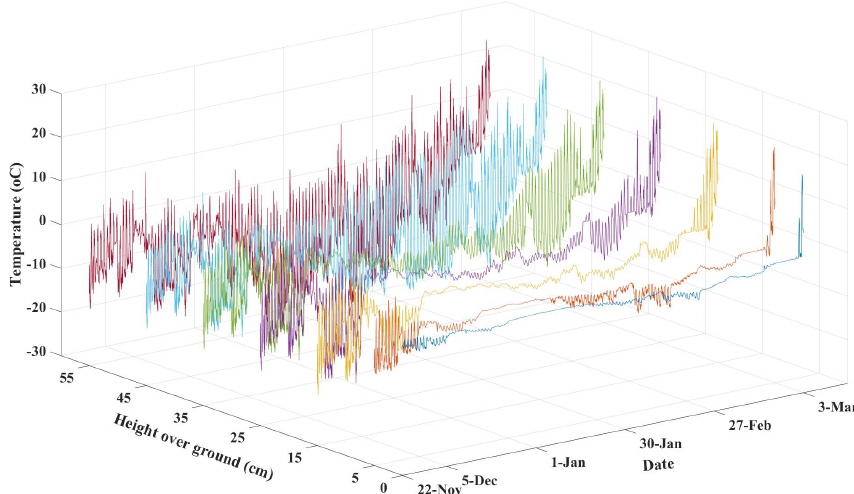
Figure 10. Minutely variation in snow temperatures at 0cm (snow/soil interface), 5, 15, 25, 35, 45, and 55cm above ground during the experiment period.